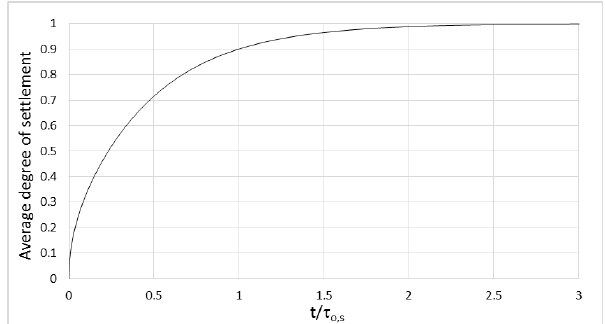
Fig. 1 Average degree of settlement evolution for the extended Davis and Raymond model with both non-constant c v and 1+e and variable